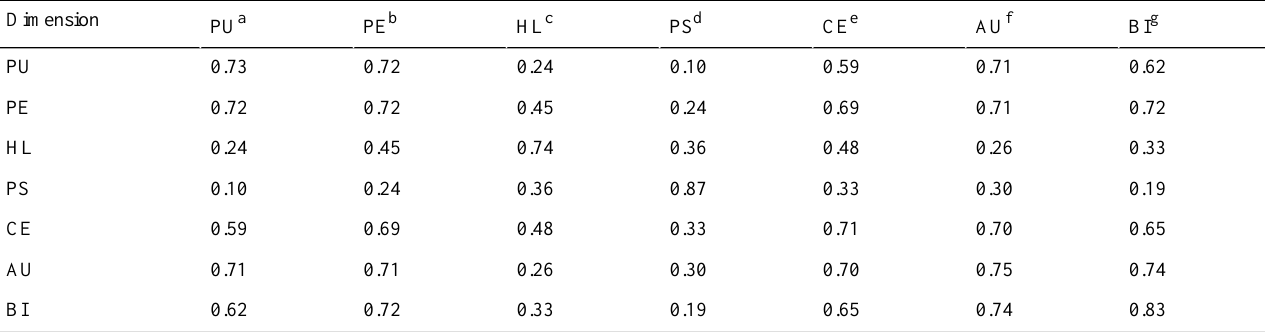
Table 4. Correlation matrix and square root of the average variance extracted. Note: The elements on the diagonal represent the square root of the average variance extracted, and off-diagonal elements represent the correlations between the